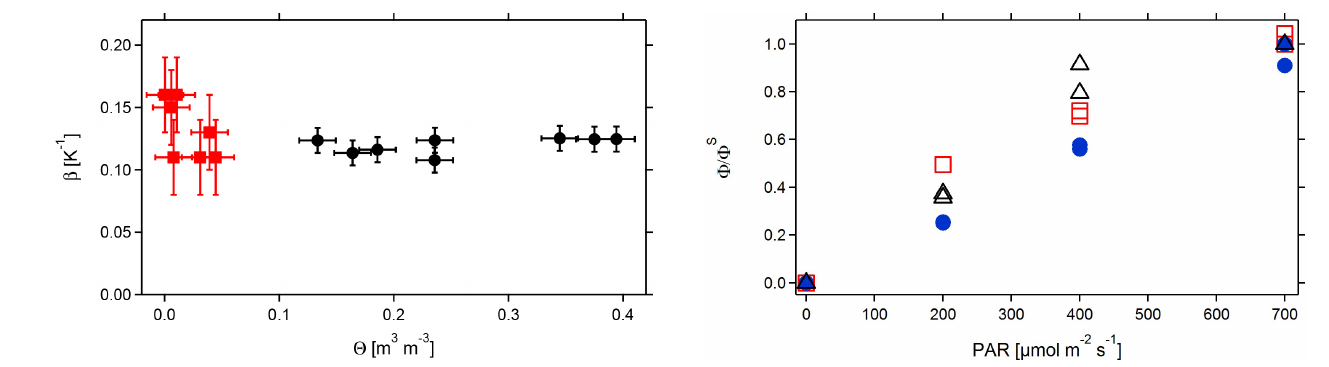
Figure 7. Emission rates corrected for the temporal decrease due to the progressing drought and normalized to the emission rates mea- sured the respective day at PAR = 700µmolm − 2 s − 1 as a function of PAR. Blue circles represent data taken at (cid:50) ∼ 0.055m 3 × m − 3 , black triangles show data taken at (cid:50) ∼ 0.043m 3 × m − 3 and red squares show the data obtained at (cid:50) ∼ 0.018m 3 × m − 3 . Experiment Holm oak 4, absolute emission rates measured at 700µmolm − 2 s − 1 dropped by a factor of about 40 with (cid:50) falling from 0.055 to 0.018m 3 × m − 3